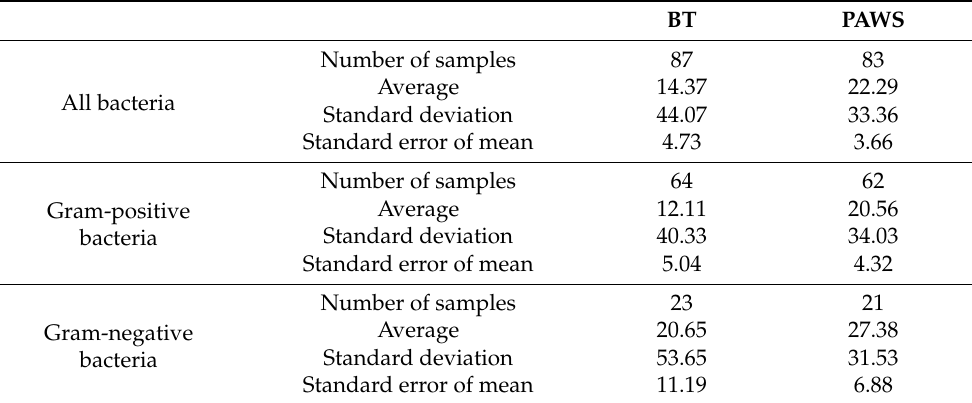
Table 1. A summary of the results of a percentage of reduced bacteria in the betadine-treated and plasma-activated water (PAW)-sprayed